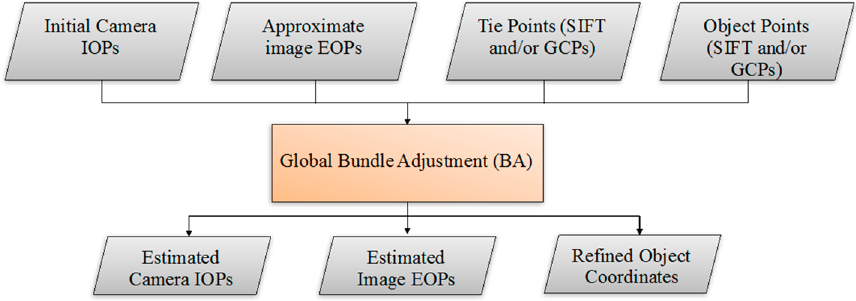
Figure 10. The inputs and outputs for the adopted global bundle adjustment.